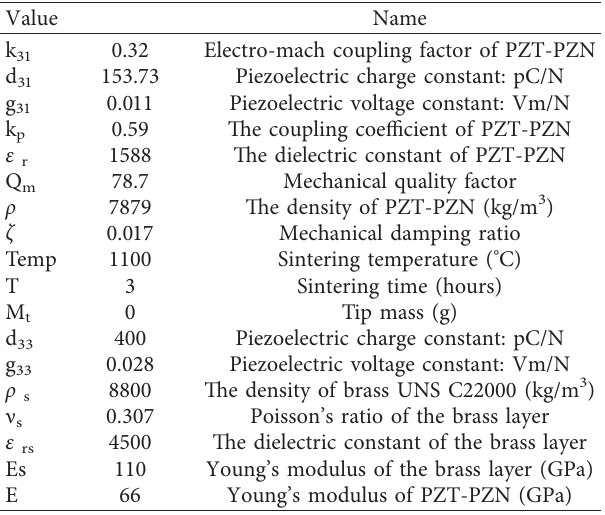
Table 1: PZT-PZN-Scheme 4 and brass material property names and values [8].